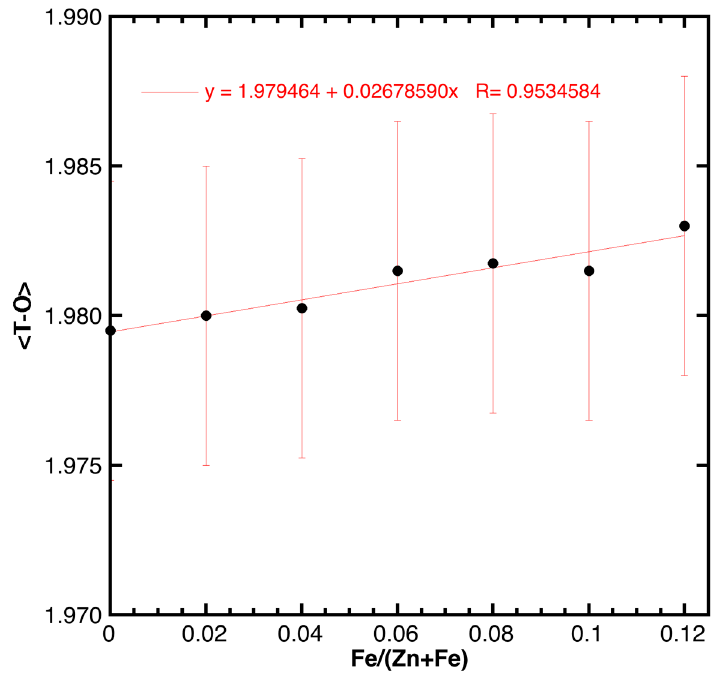
Figure A2. <T–O> distance as a function of the Fe concentration.